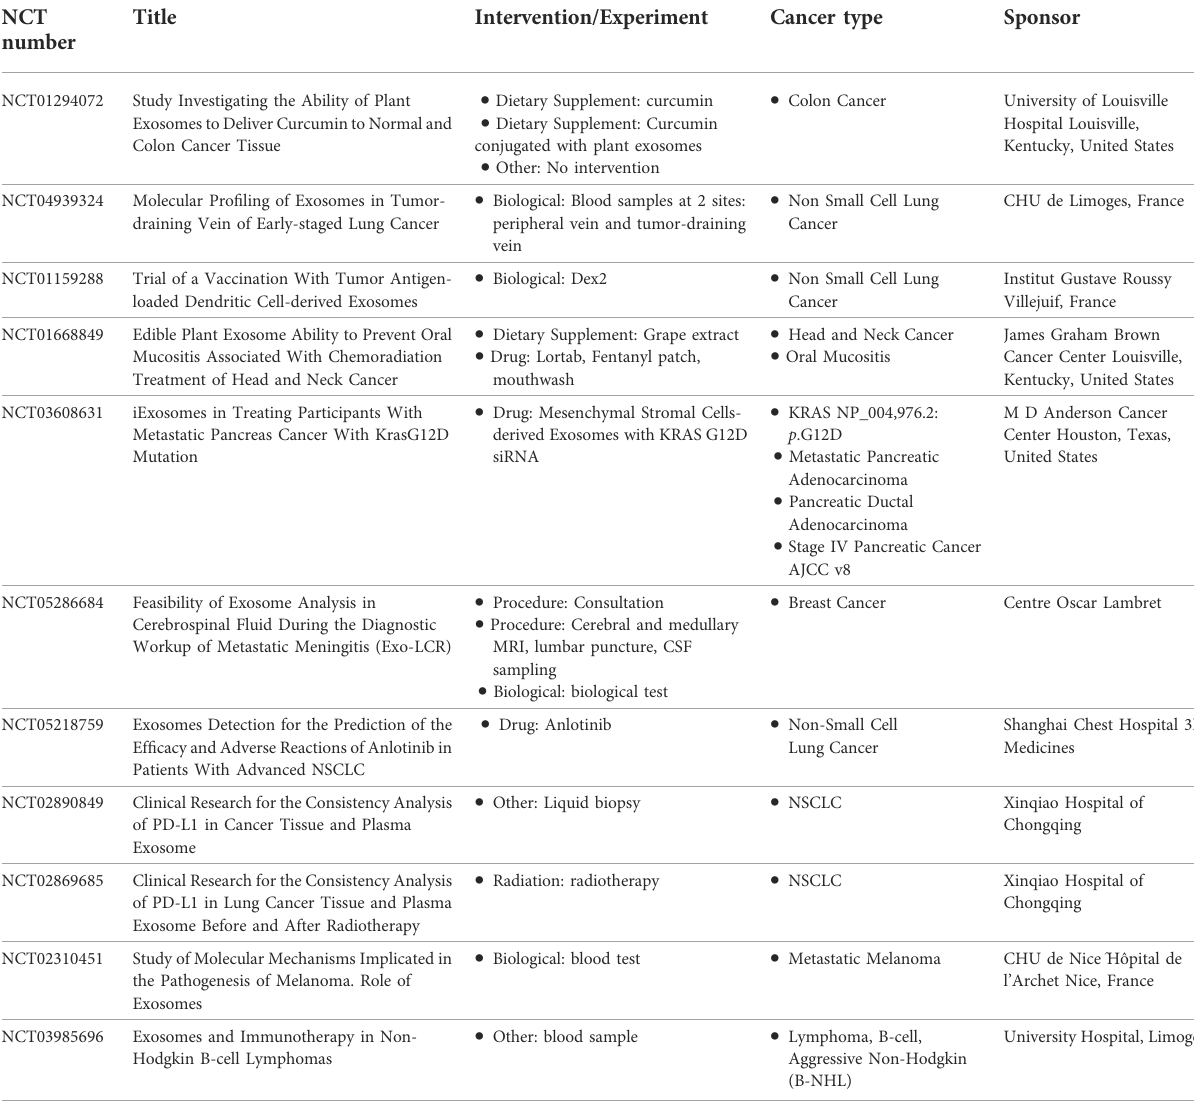
TABLE 3 Exosomes-based clinical trials registered in ClinicalTrials.gov (https://www.clinicaltrials.gov/). NCT